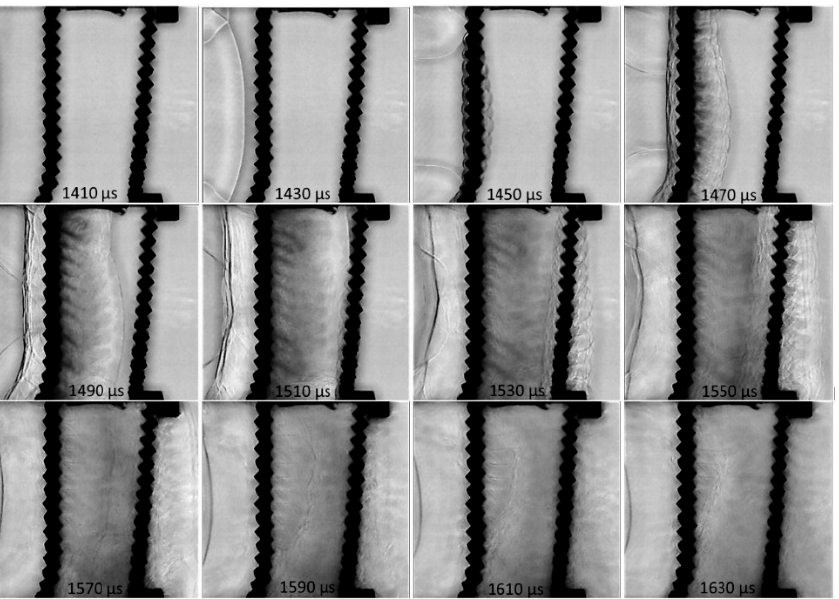
Figure 11. Photographic results of high-speed video recording, showing shock wave propagation through one plate of deployed metal (20 µs between each photograph).